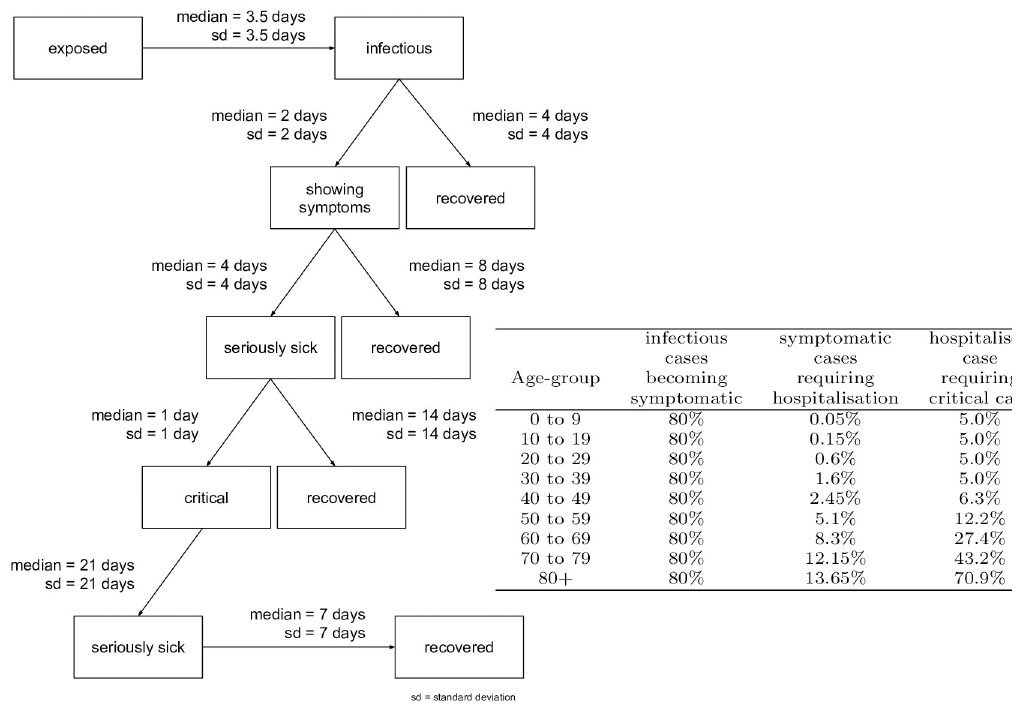
Fig 3. Disease progression model. LEFT: State transitions [70–75]. RIGHT: Age-dependent transition probabilities from infectious to symptomatic, from symptomatic to seriously sick (= requiring hospitalisation), and from seriously sick to critical (= requiring breathing support or intensive care). Source: [15], except that the numbers in the second column are divided by 2 (discussed in Under-reporting, and its variation over